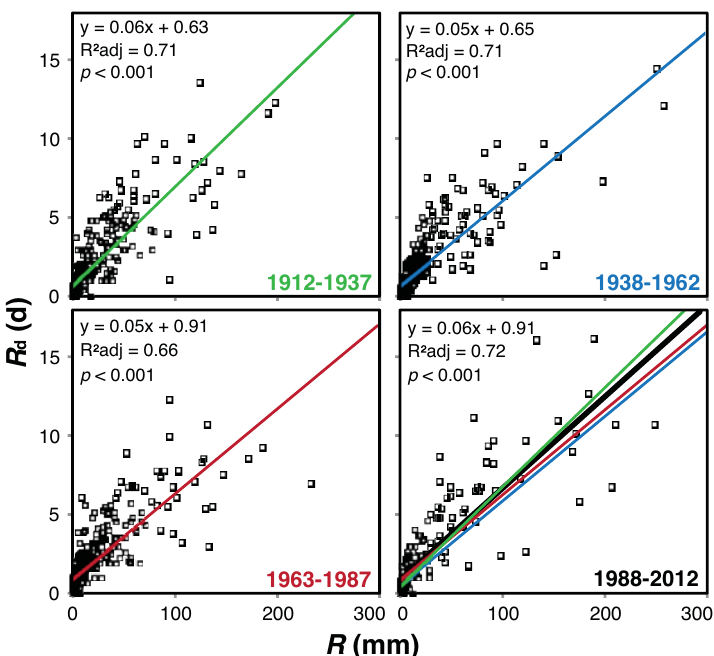
Figure A4. Collinearity between R and R d over the last century (1912–1937; 1938–1962; 1963–1987) compared to the calibration